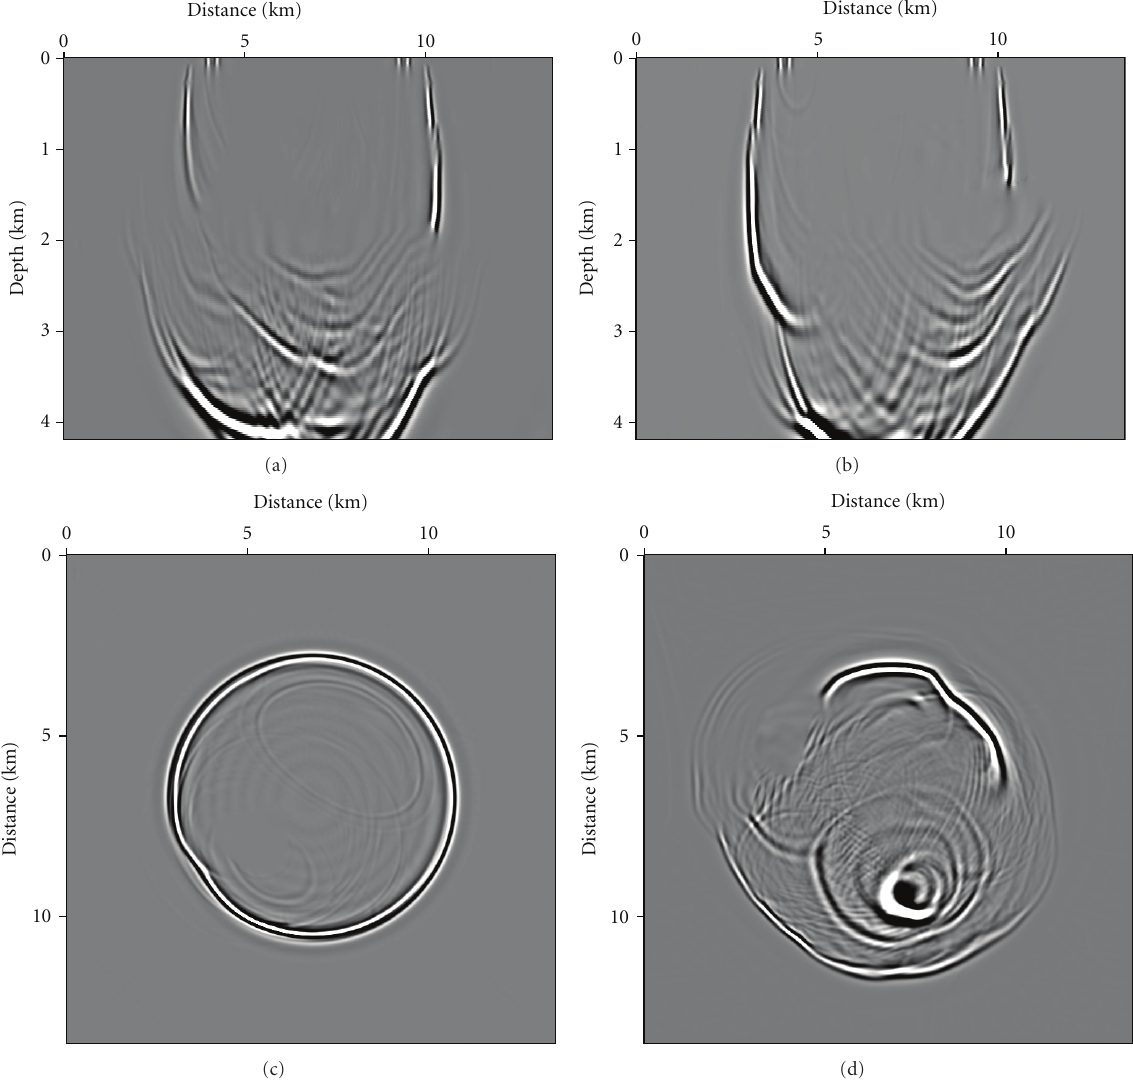
Figure 2: Impulse response obtained by FFDPI migration represented by 4 cross-sections at x = 8 . 32km (a), y = 8 . 32km (b), z = 1 . 1km (c), and z = 2 . 7km